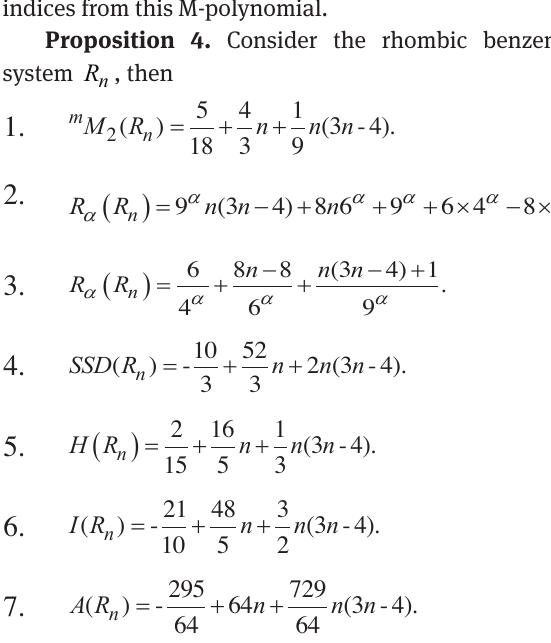
Figure 6: The plot for the M-polynomial of